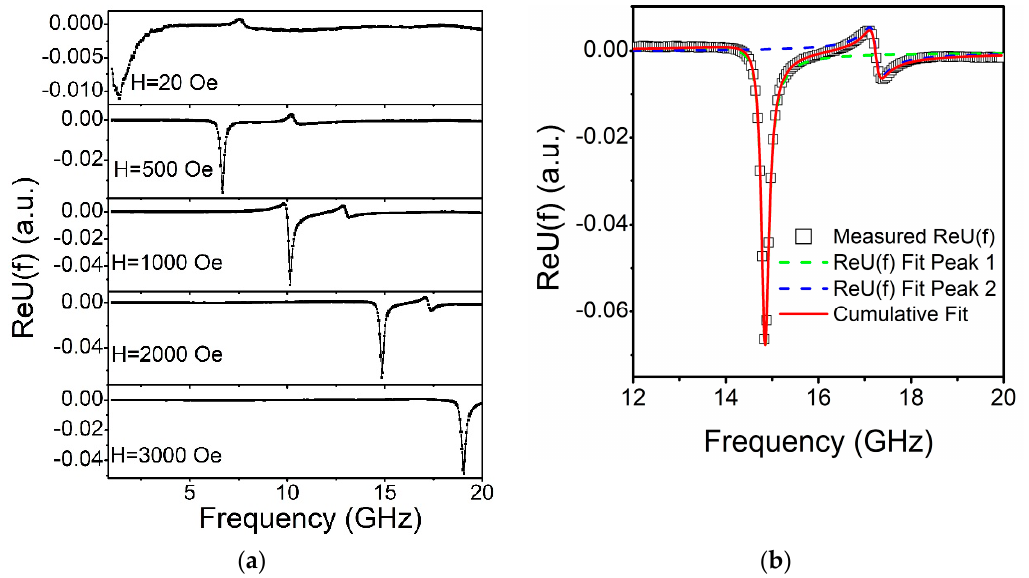
Figure 4. Real part of the U(f) function calculated from measured complex S 21 spectrum for the film deposited at T S = 573 K at different applied fields ( a ); Example of fitting of permeability Re U(f) for the same sample at a static applied field H ext = 2000 Oe ( b ). The open circles represent the Re U(f) values extracted from the experimental S 21 parameters. The two dashed lines show the best individual fitting functions Re U fit (f) for each peak while the solid curve shows cumulative fit for the whole spectrum.